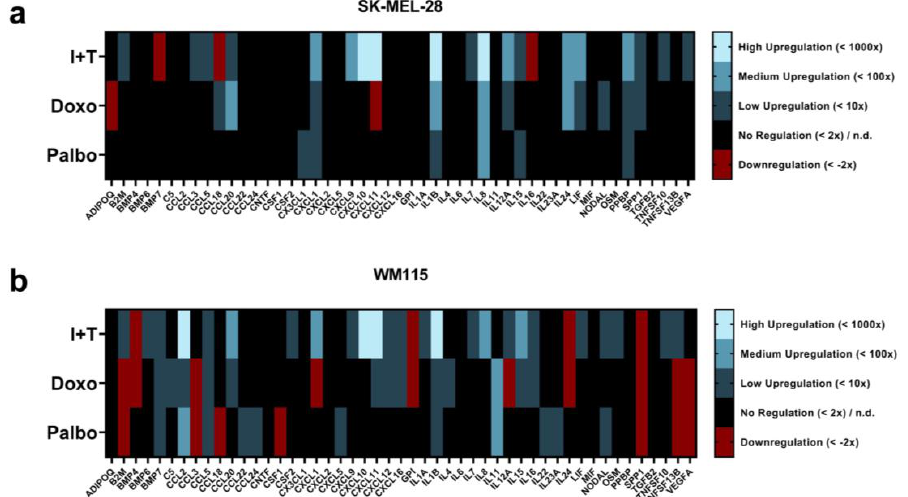
Figure A2. Gene expression profile of cytokines and chemokines in SK-MEL-28 ( a ) and WM115 ( b ) melanoma cells treated with IFN- γ and TNF (I+T), doxorubicin (Doxo), and palbociclib (Palbo). qPCR array analysis was performed 48 h after the end of treatment. Gene expression of cytokine- treated cells was normalized to the medium control, whereas gene expression of doxorubicin- and palbociclib-treated cells was normalized to the respective DMSO control. Results are from two in- dependent experiments ( n = 2) and show the mean expression value with a variation of less than 20%.